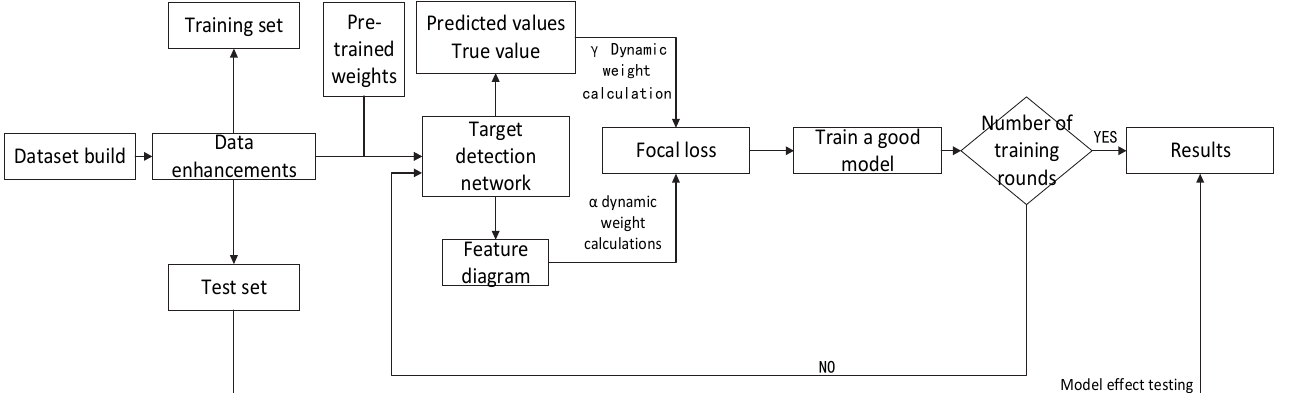
Figure 3. Detection process of insulators on transmission line.